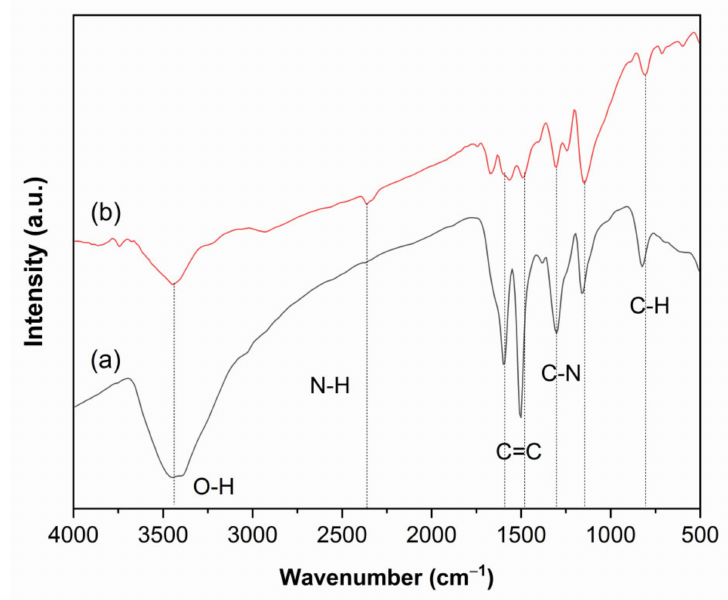
Figure 5. FT-IR spectra of ( a ) PANI@AH36 and ( b )